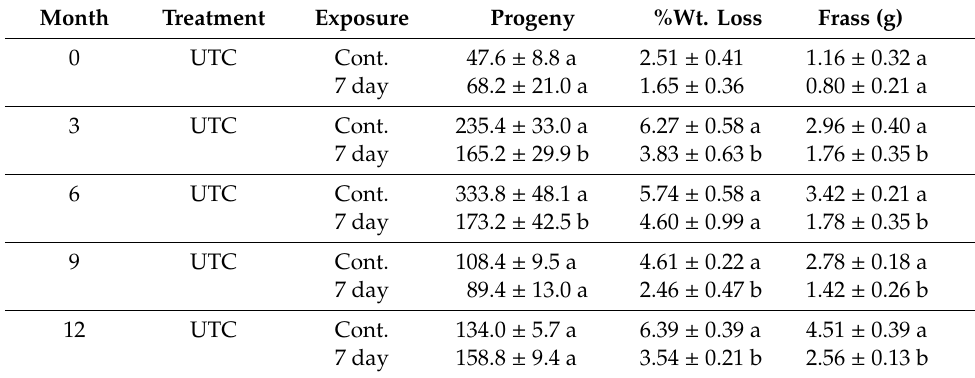
Table 3. Number of F 1 adult progeny, % of sample weight loss due to insect feeding, and feeding damage (frass) (mean ± SE for all) from exposure of ten mixed-sex parental adult R. dominica exposed continuously for about 8 weeks (Cont.) on ~80 g of untreated wheat (UTC), or parental adults were removed after 1 week and samples were held for an additional 8 weeks (7 day). Data are separated by month. No progeny development on wheat treated with low and high rates of Diacon IGR + or the Gravista formulation; no overall ANOVA done, only comparison between the two parental exposure regimes. Data are separated by month, bioassays were done at 1 day (month 0), and 3, 6, 9, and 12 months after treatment 1 .